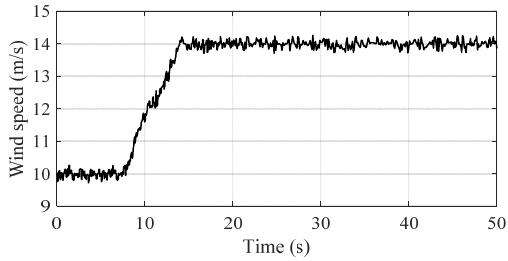
Figure 20. The fluctuating wind speed in case II.